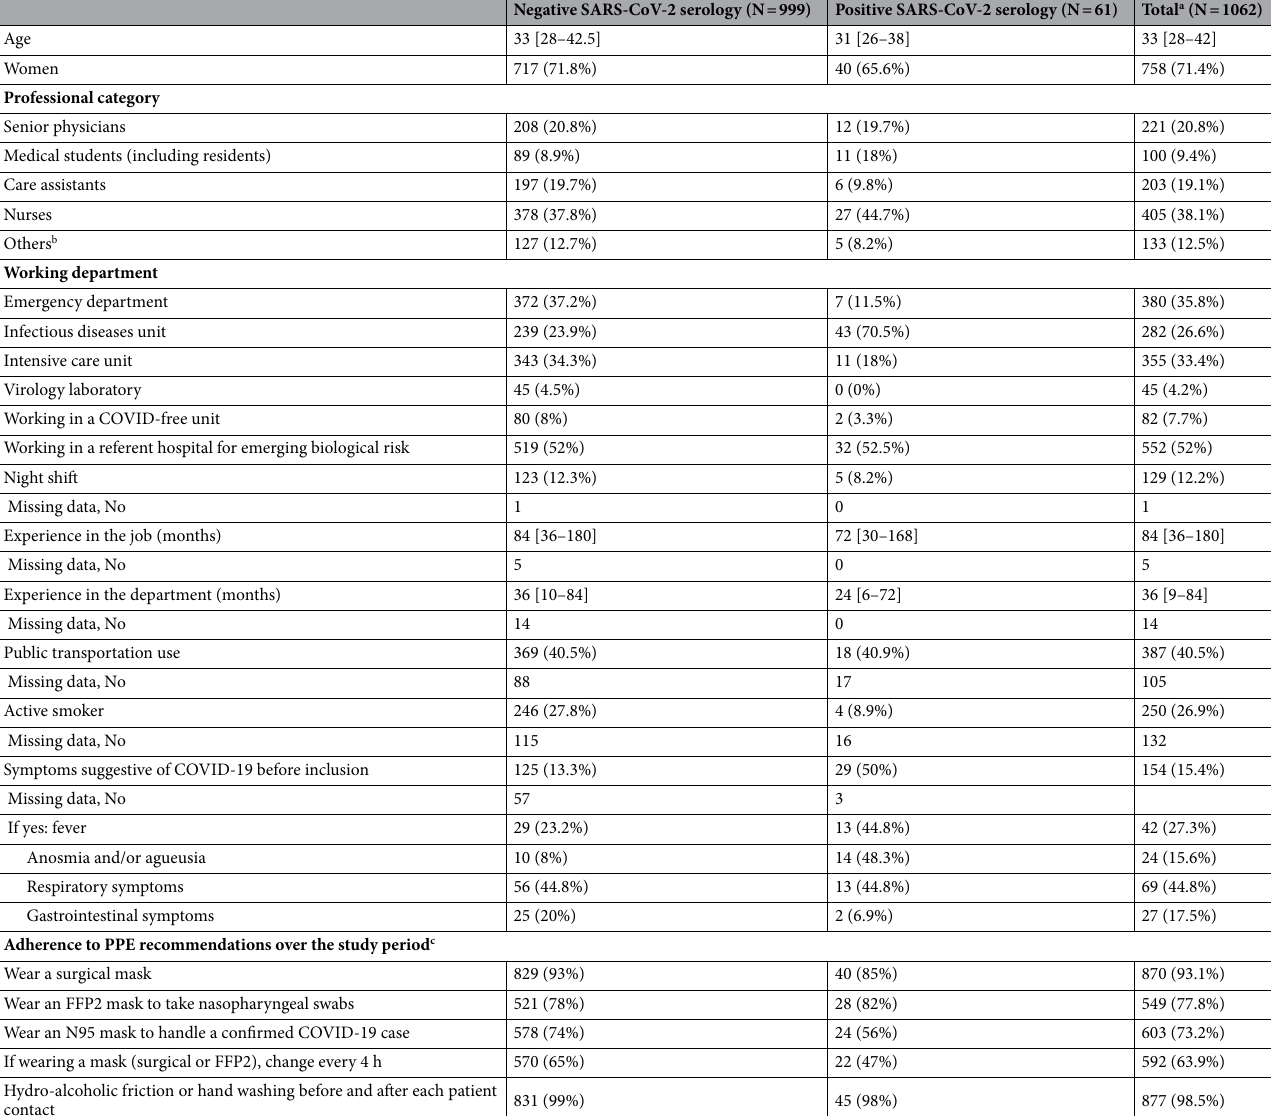
Table 1. Baseline characteristics of the study population according to SARS-CoV-2 serology at inclusion. Data are n (%) for qualitative variables and median [interquartile range] for quantitative variables. a HCWs with positive, negative or missing (n = 2) serology at inclusion, thus 2 more individuals than the sum of the 2 other columns. b Others include (but not limited to): secretaries, nurse’s managers, social workers. c Collected at